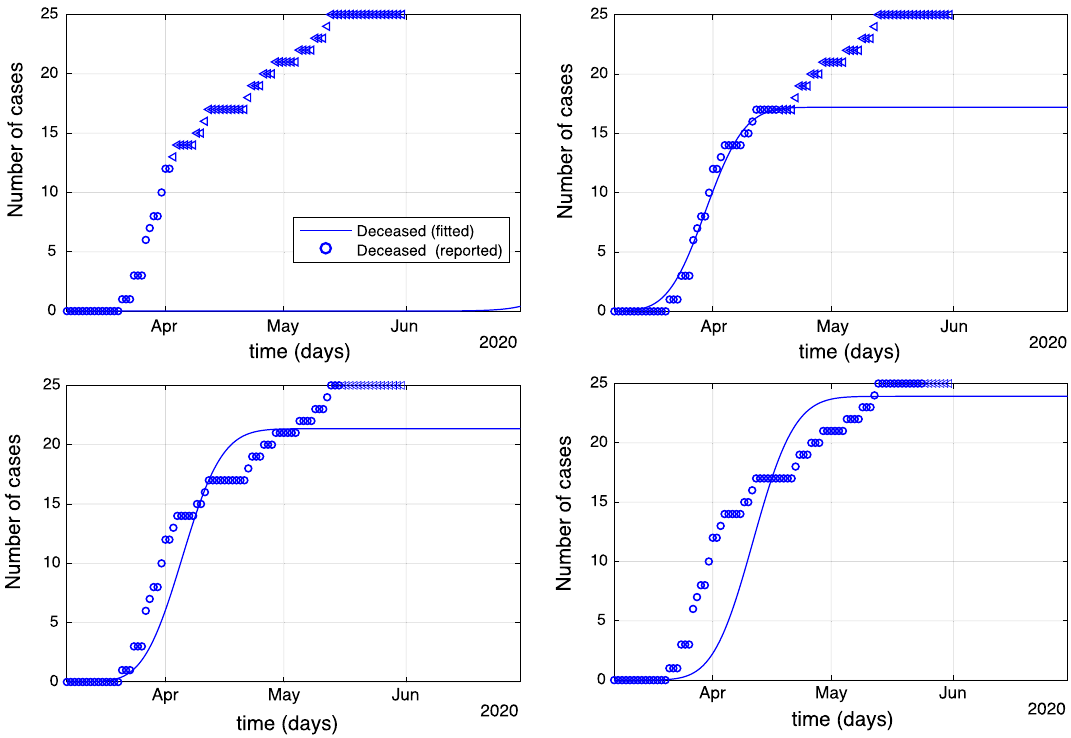
Figure 3. Predictions obtained after fitting (6) for the number of deaths until the end of the observation period. Parameter estimation was performed by subsampling the data until 2/4/2020 (top left), 15/4/2020 (top right), 15/05/2020 (bottom left), 24/5/2020 (bottom right). Corresponding RE’s equal 2%, 4% and 8% clockwise from top right to bottom